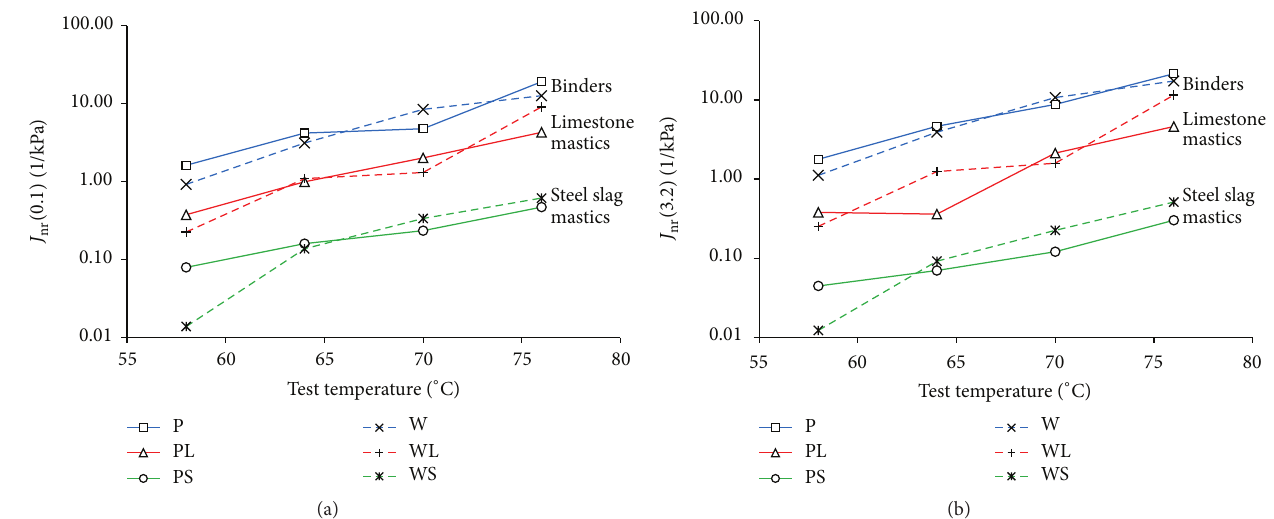
Figure 9: Nonrecoverable creep compliance ( 𝐽 nr ) of binders and mastics at 0.1 (a) and 3.2 (b)